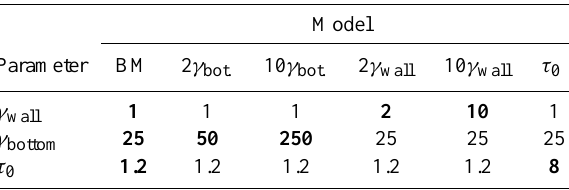
Table 3. Studied parameters for the sensitivity analysis: boundary heat dissipation (at the walls and at the bottom) and gas diffusion enhancement factor ( τ 0 ). Compared to the base model (BM): the boundary heat dissipation, by means of γ value, has been doubled and increased by an order of magnitude alternatively and τ 0 value for the upper material (firsts 1.5cm) has been increased from 1.2 to 8 to equal the value for all the column.